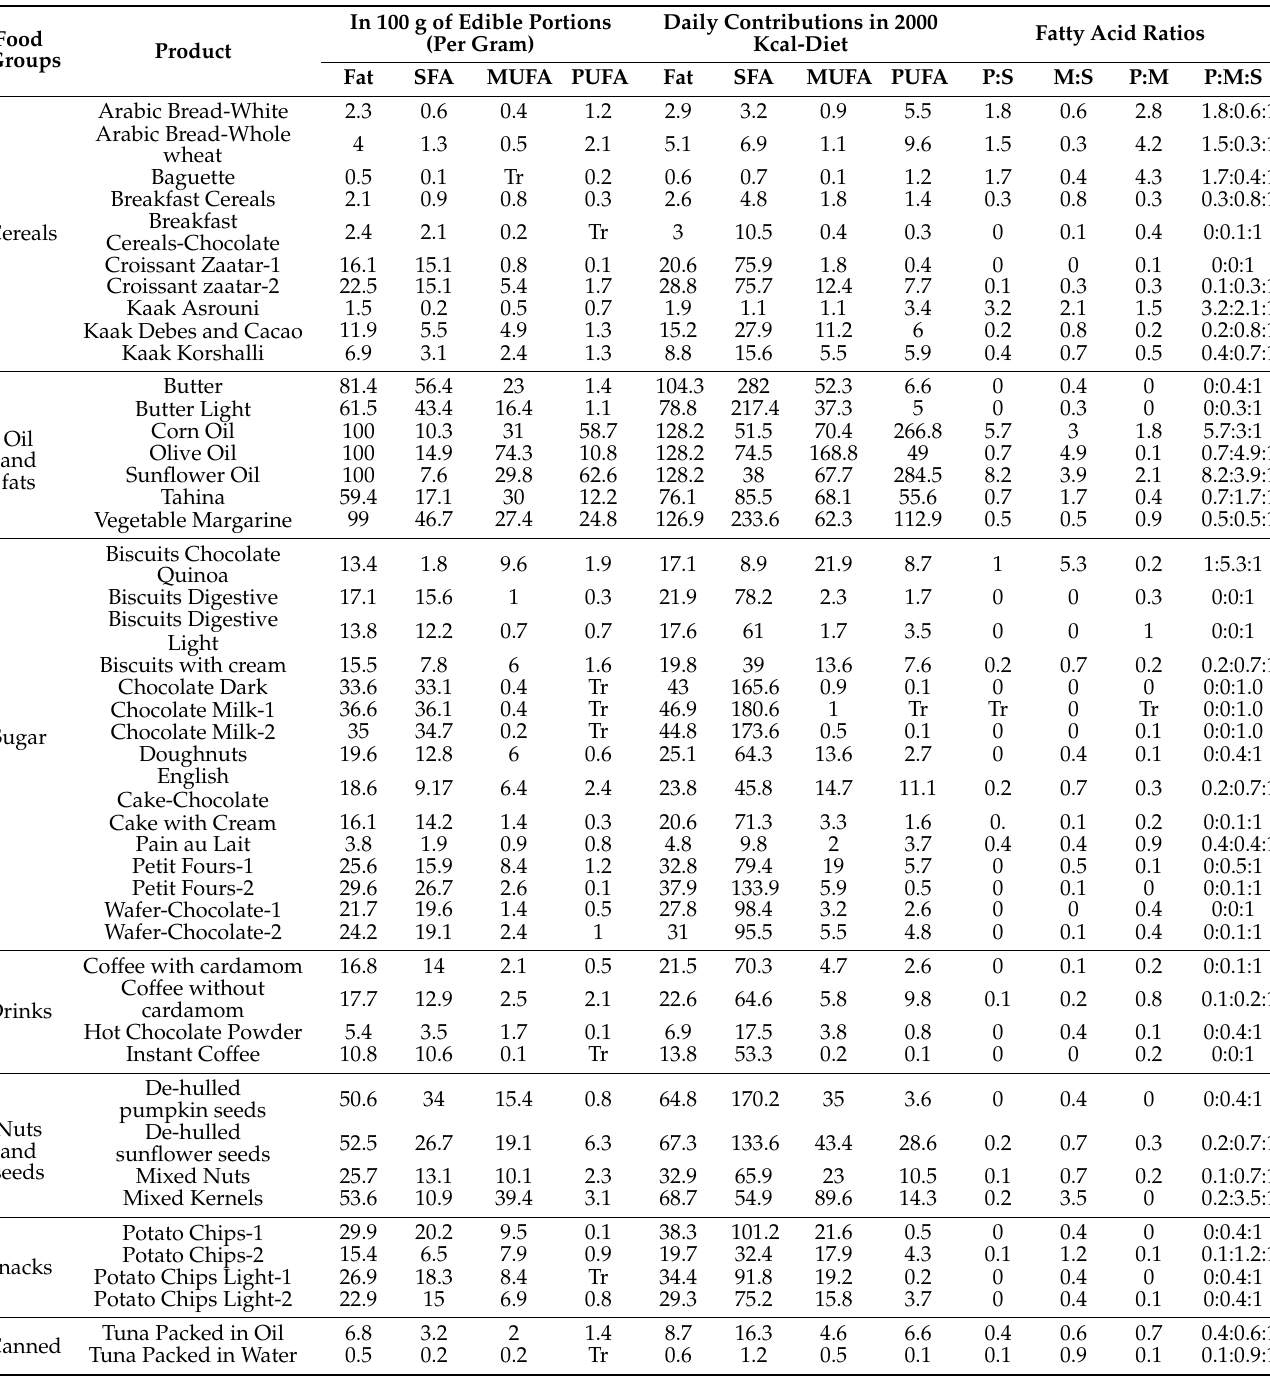
Table 3. Fatty acid ratios and total fatty acid content in 100 g of edible portions of market food products and the percentage of their daily contribution in a 2000 Kcal-diet.